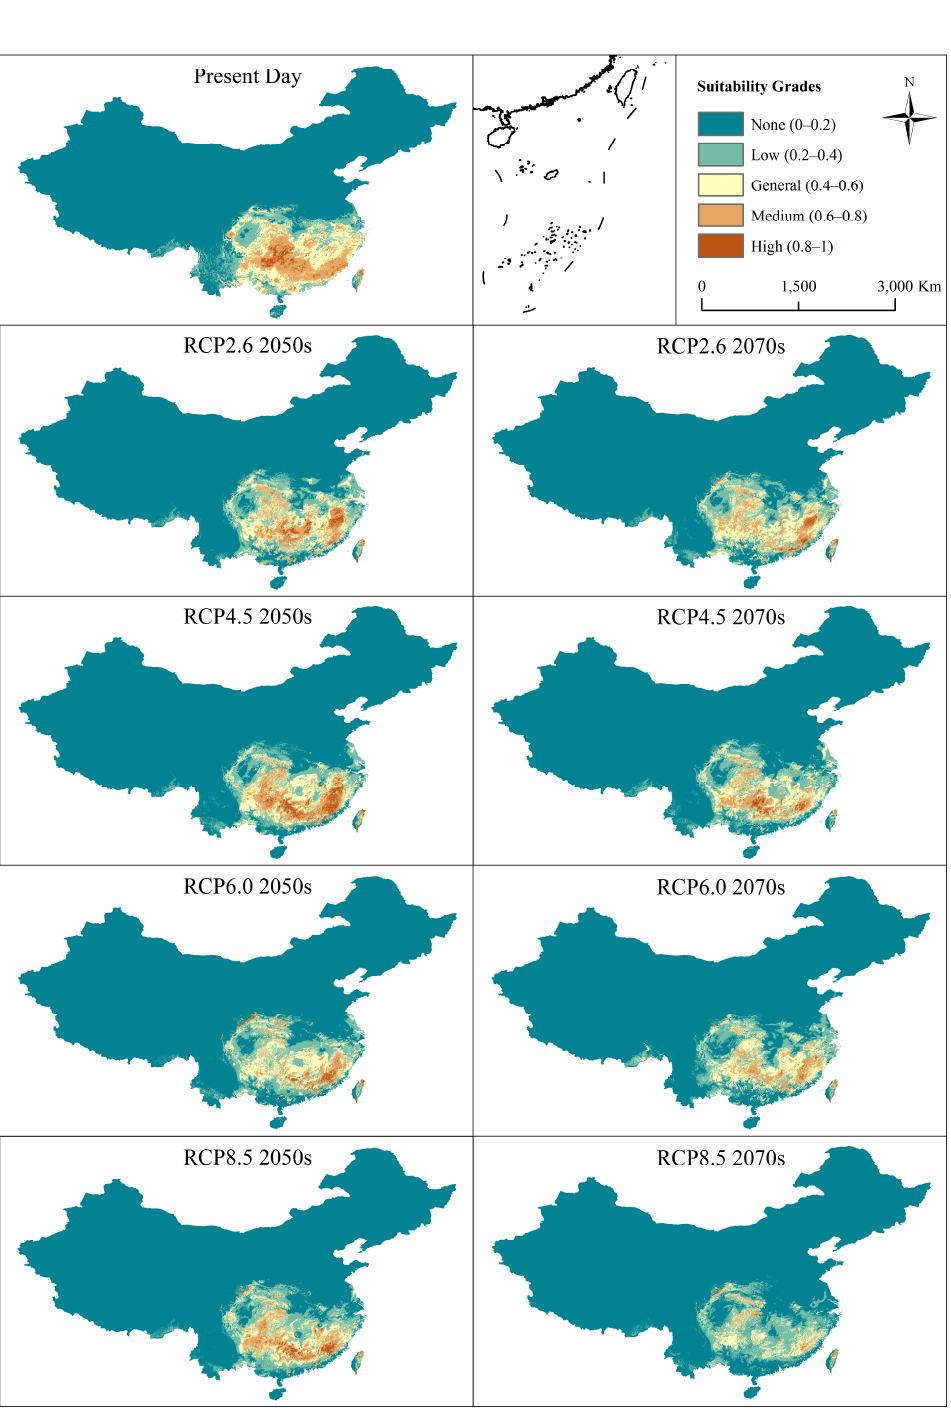
Figure 5. Prediction of potential suitable distribution area for Cunninghamia lanceolata during the present day, 2050s, and 2070s under different climate scenarios in China. RCPs: Representative Concentration Pathway data defined by the possible range of radiative forcing values (2.6, 4.5, 6.0, and 8.5 W/m 2 , respectively) in the year 2100 taken from the Beijing Climate Center Climate System Model version 1.1 (BCC-CSM1-1) included in the IPCC Fifth Assessment Report (AR5).